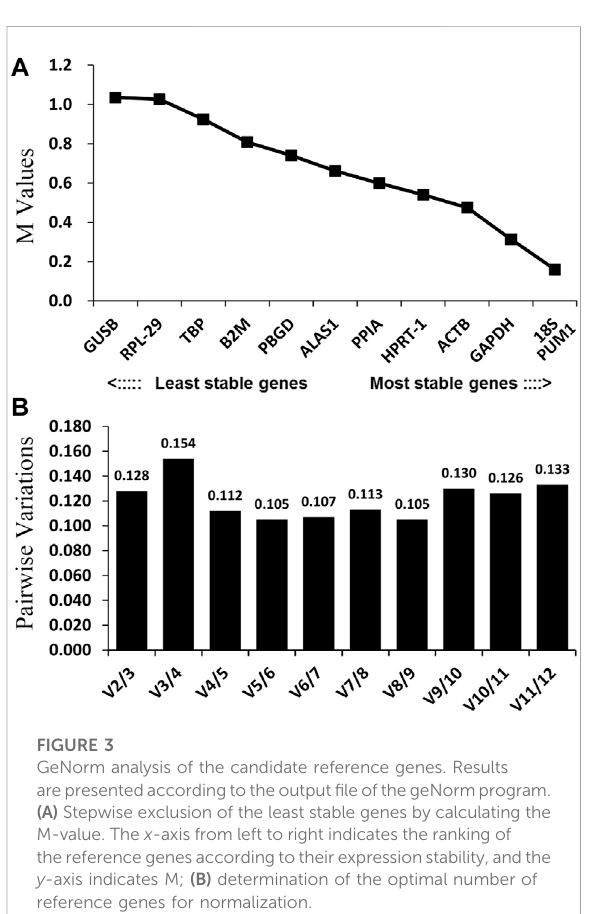
FIGURE 3 GeNorm analysis of the candidate reference genes. Results arepresentedaccordingtotheoutput fi leofthegeNormprogram. (A) Stepwise exclusion of the least stable genes by calculating the M-value. The x -axis from left to right indicates the ranking of thereferencegenesaccordingtotheirexpressionstability,andthe y -axis indicates M; (B) determination of the optimal number of reference genes for normalization.